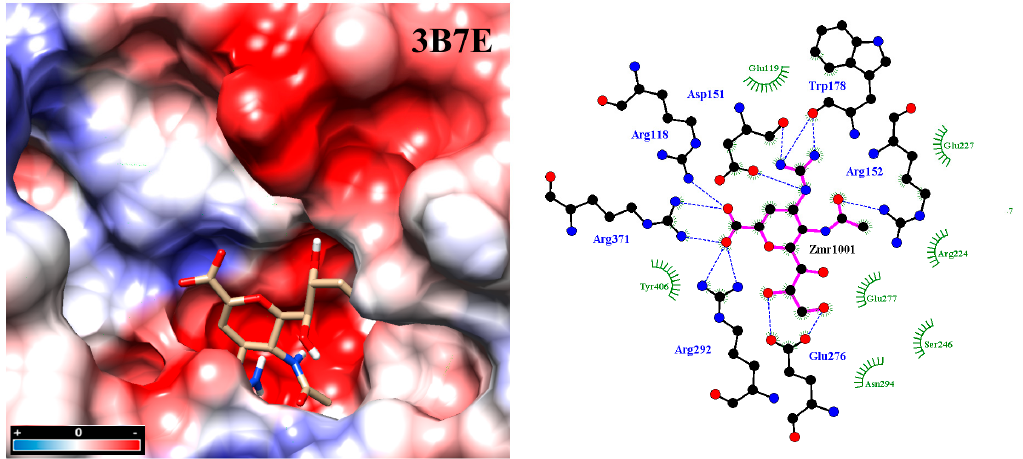
Figure 2. Molecular docking between zanamivir molecule with neuraminidase subtype N1 3B7E. Intensive hydrogen bond networking helps stabilize inhibitor binding at the active site, in addition to hydrophobic interactions. Analysis was carried out with the program PrPx-Phyton v0.8 (Autodock Vina). The 3D model surface was colored by the Coulombic Surface tool under UCSF Chimera 1.11.2. LigPlot v.1.4.5 analyzed the final docked poses. Dotted blue lines symbolize hydrogen bonding while semicircles with tabs show hydrophobic interactions.